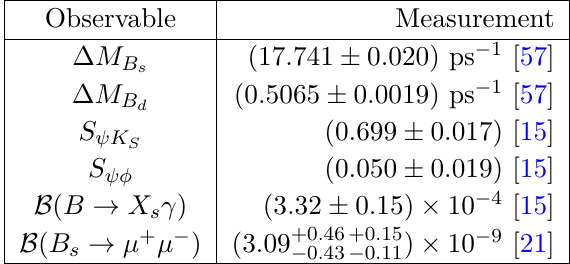
Table 1 . Experimental data of various B meson